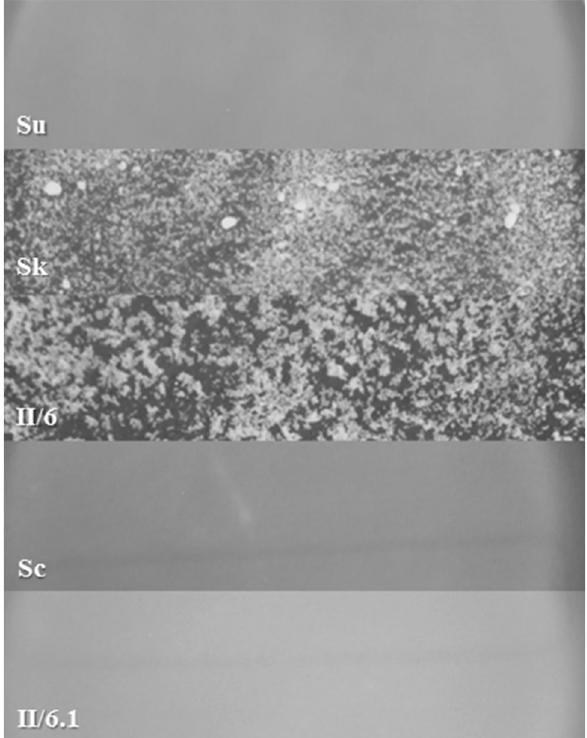
Figure 5. Flocculation of cells. Su: 10–1651 S. uvarum . Sk: 1653 S. kudriavzevii . II/6 two-species kudvarum hybrid. Sc: 10–170 S. cerevisiae . II/6.1: three-species cekudvarum